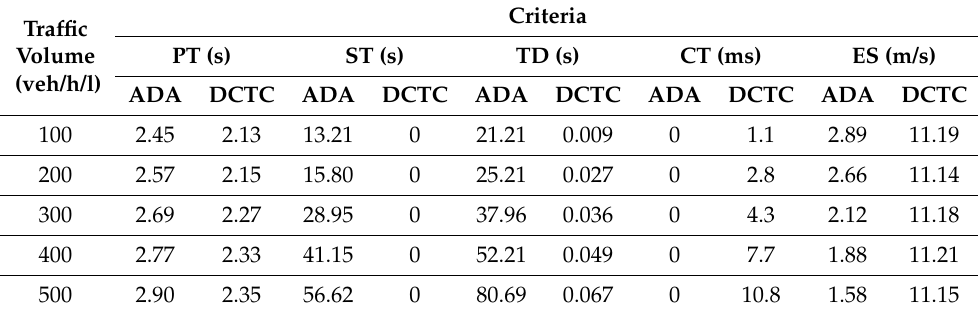
Table 7. Traffic control performance comparison between DCTC and